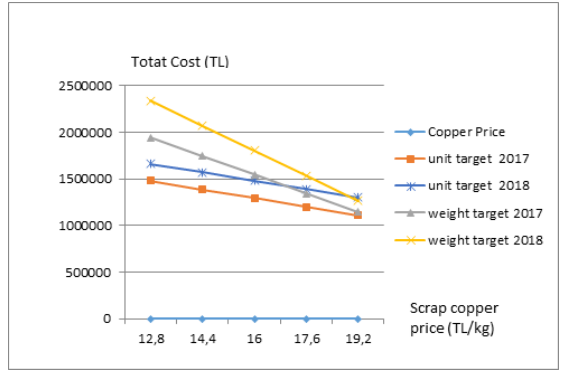
Figure 4. Sensitivity analysis for the scrap prices of copper metal